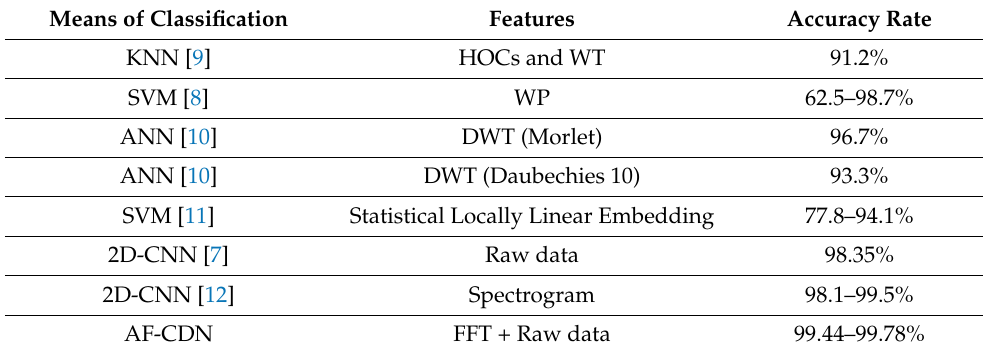
Table 4. Comparison of diagnostic accuracy of different